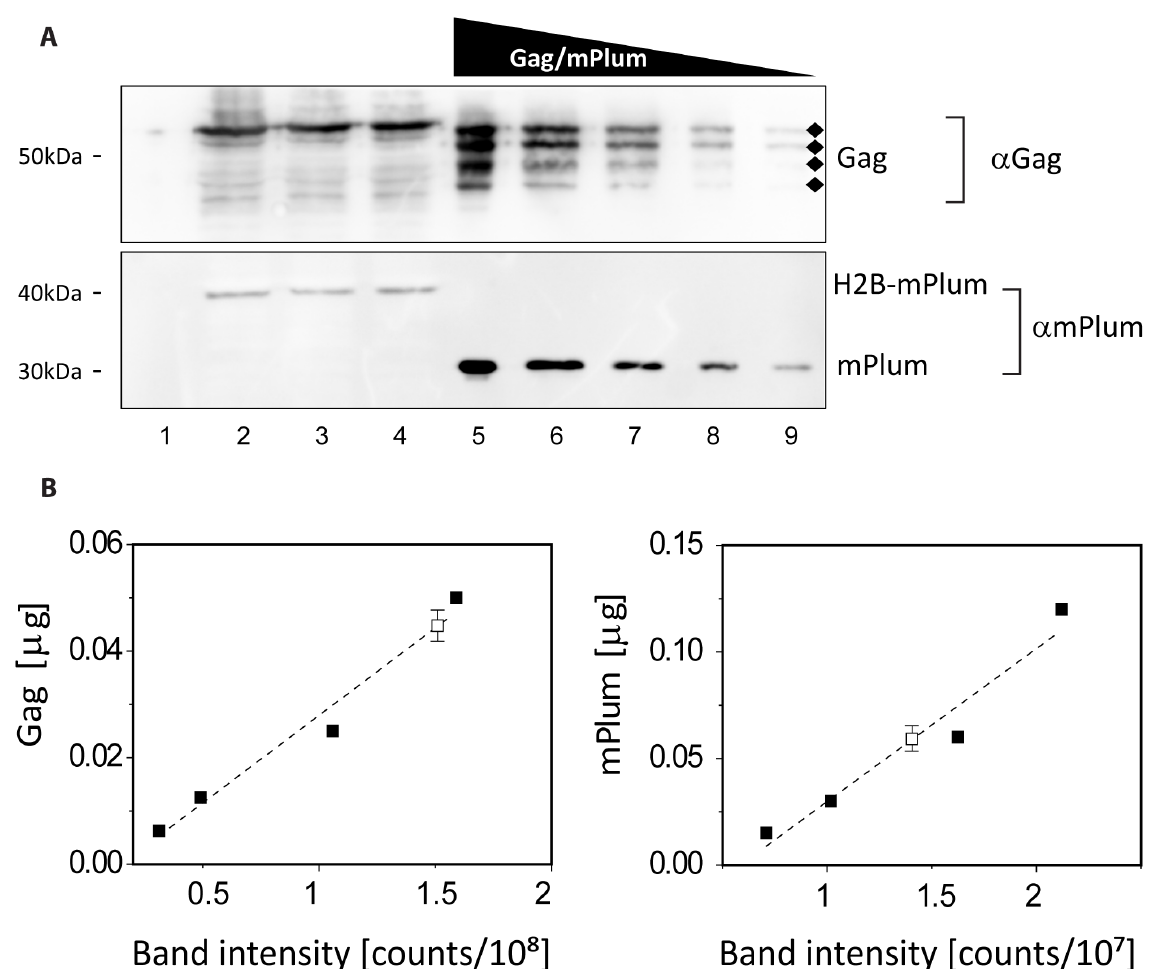
Figure 2. Quantifying the bulk expression levels of H2B-mPlum and Gag. ( A ) Quantitative western blot. Lane 1: non-transfected cells. Lanes 2, 3, 4: biological replicates of total cell extracts from Cos7 cells transfected with the pH2B-mPlum/Gag construct. Gag (the diamonds indicate bands corresponding to degradation products that were included in the quantification) and H2B-mPlum were detected using specific anti-Gag and anti-RFP antibodies. Lanes 5, 6, 7, 8, 9: purified Gag (upper panel) and mPlum (lower panel) ranging from 6.25 to 100 ng and 15 to 240 ng respectively. ( B ) Calibration curves obtained from serial protein dilutions (closed squares, from lanes 5–9) and measured Gag and H2B-mPlum concentration in cell extracts (open square, from lanes 2–4, mean and standard deviation for the triplicate are shown). The bands corresponding to the highest concentrations were omitted in the fit, their intensity being close to